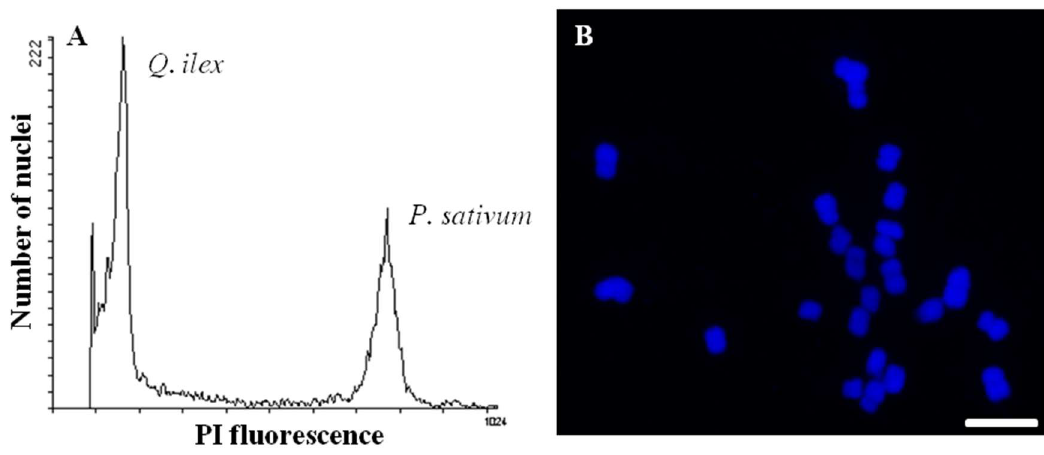
Figure 2. ( A ) Uniparametric histograms of fluorescence intensities of the nuclei of Q. ilex and Pisum sativum , used as a control, after staining with propidium iodide (PI). The 2C nuclear DNA content of P. sativum is 9.09 pg. ( B ) Somatic chromosomes in root tip cells of Q. ilex . Scale bar = 10 µm.